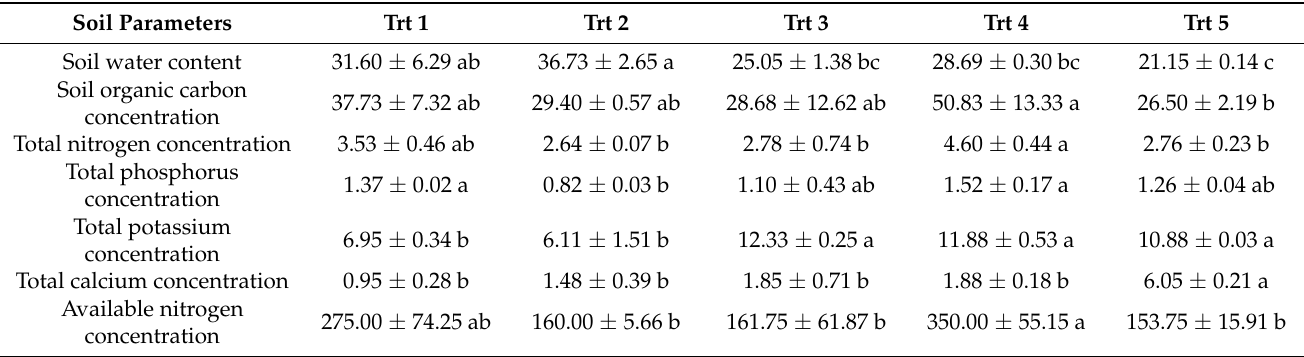
Table 2. Soil parameters in different planting